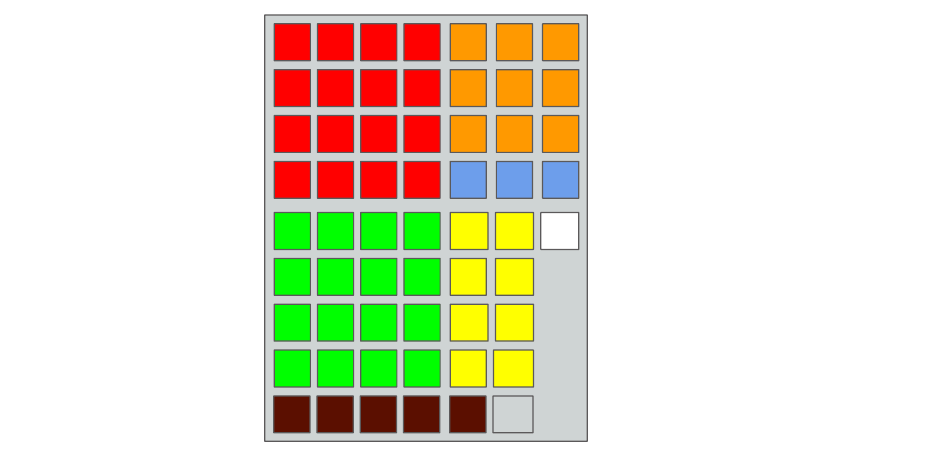
Figure 3. Allocating jobs within a fat node: the DIRAC pilot, when using the Pool inner Computing Element, realizes a de-facto partitioning of the node, and parallel jobs matching. The figure above shows a theoretical allocation of jobs to logical processors, with each box representing a logical processor. Each color represents a di ff erent application.